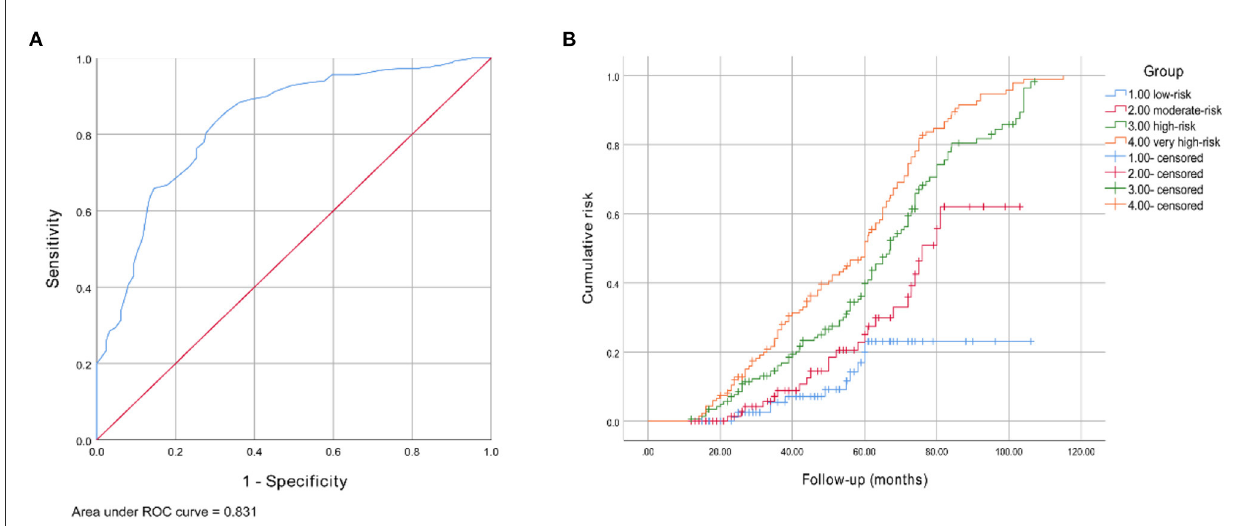
FIGURE4 (A) Receiver operating characteristic curve for the DPN risk prediction model. The AUC and 95% CI were 0.831 (0.794–0.868). (B) Kaplan-Meier curve of DPN end point for four risk group: moderate- (RR 3.3, 95% CI 1.5–7.2, P = 0.020), high- (RR 15.5, 95% CI 7.6–31.6, P < 0.001), and very high-risk